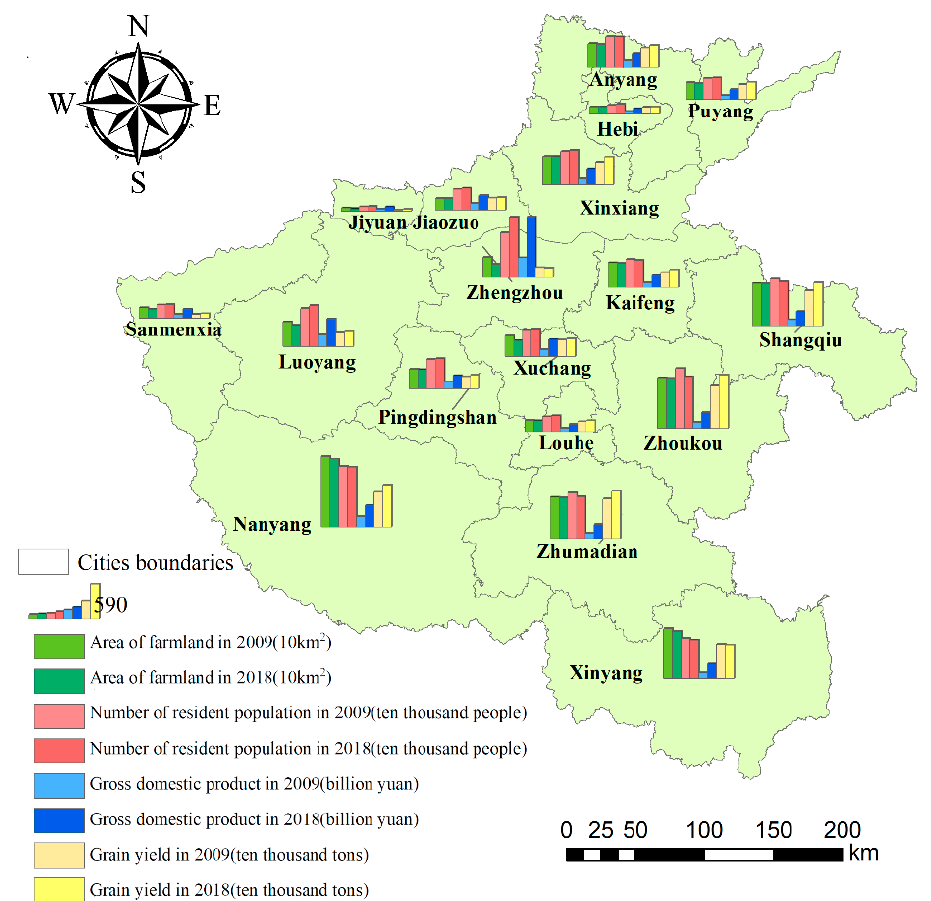
Figure 7. Changes of factors in different cities of Henan province from 2009 to 2018.